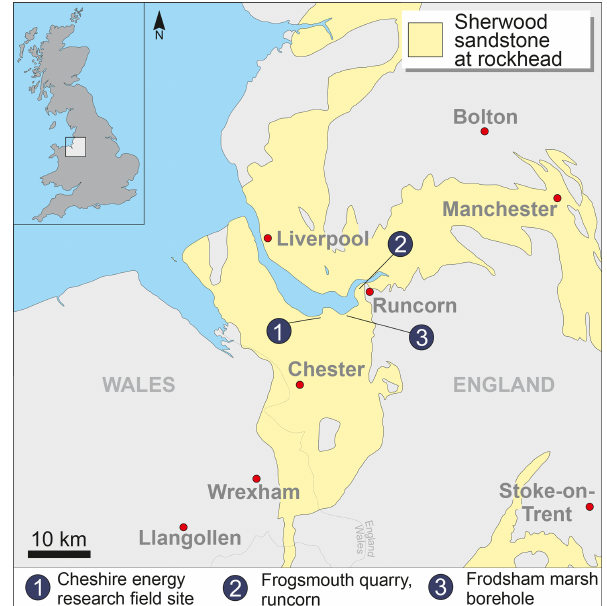
Figure 1. Location map showing the generalised distribution of the SSG at rockhead. © UKRI 2019, British Geological Survey, con- tains Ordnance Survey data © Crown Copyright and database rights 2019 [licence number 100021290 EUL].